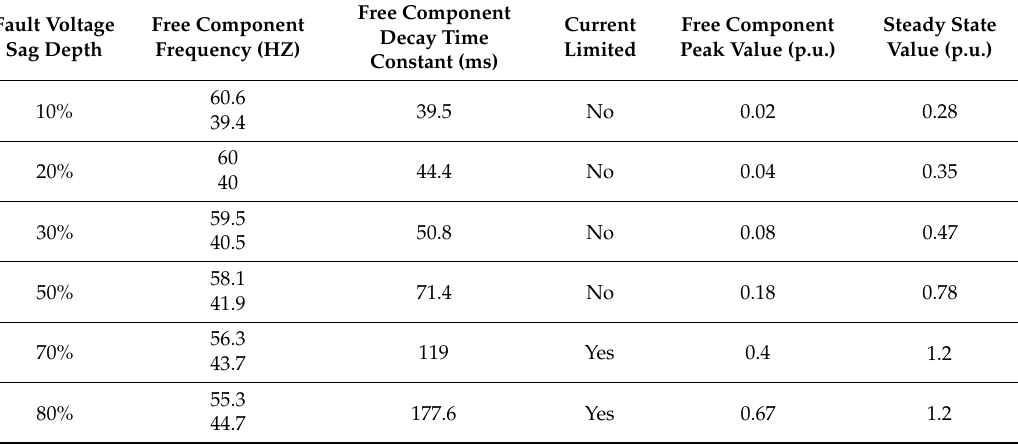
Table 3. Influence of fault voltage sag depth.